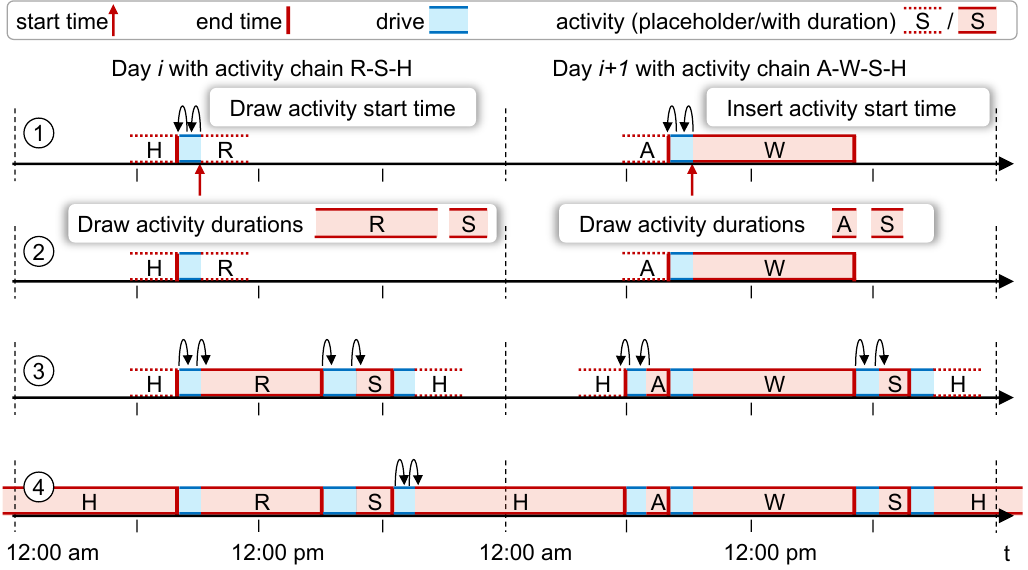
Figure 8. Exemplary illustration of the four process steps of assigning an end time and duration to each activity. The red arrow in step one marks the drawn or inserted start time. Vertical red lines represent activity end times. Bent arrows illustrate that that element at the head of the arrow can uniquely be located on the timeline given the element the arrow originates from. Blue and red represent driving and activity, respectively. Drive times are exaggerated for illustrative